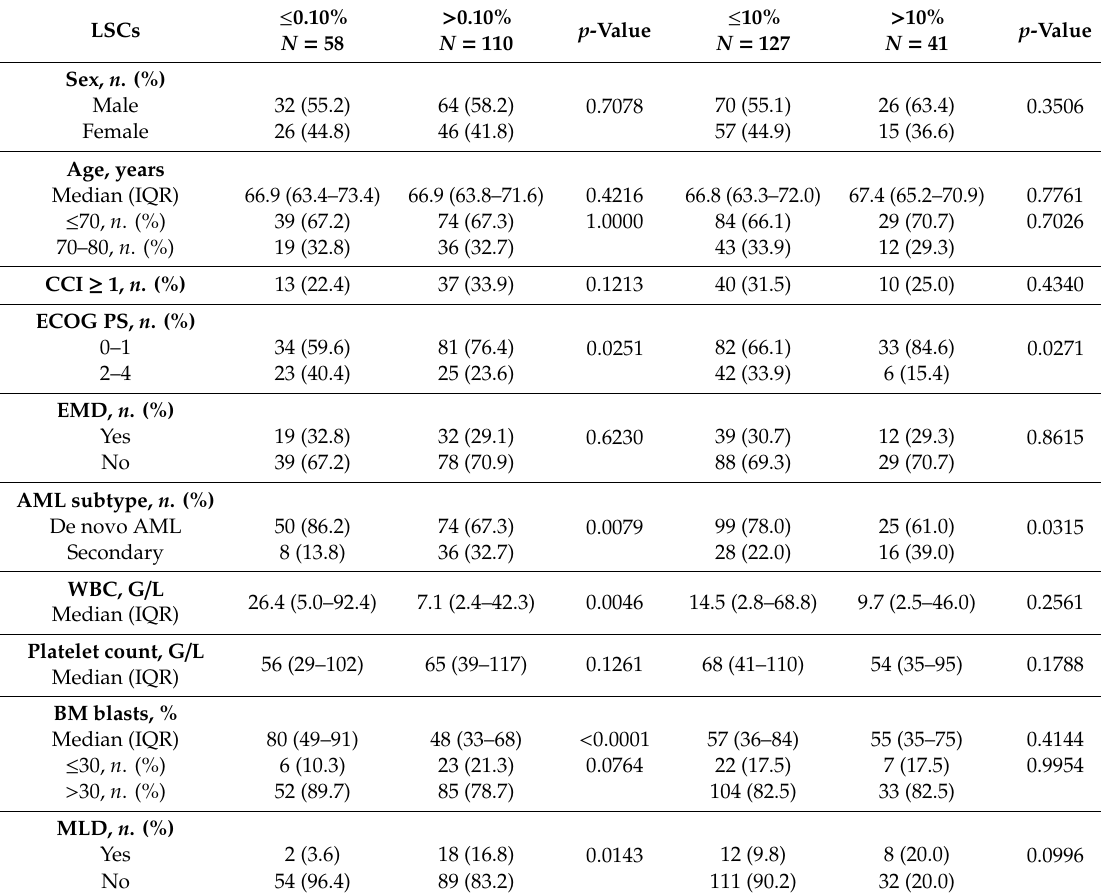
Table 5. Characteristics of AML patients treated by intensive chemotherapy according to the % of leukemic stem cells